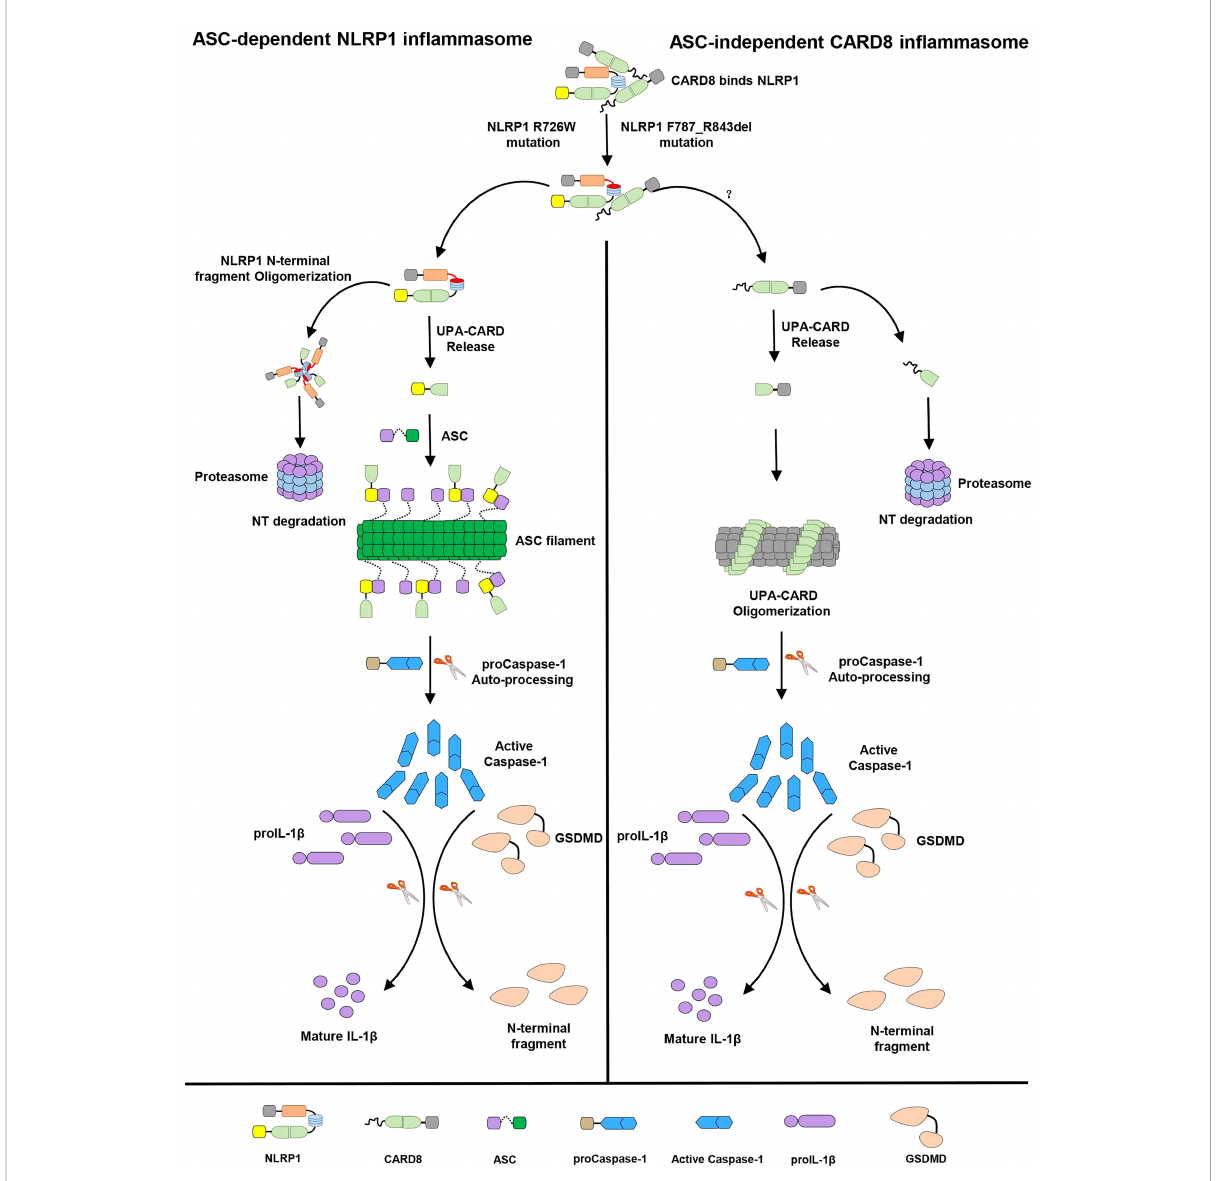
FIGURE 7 The sequential regulation and activation model of NLRP1 and CARD8 in fl ammasome. Full-length NLRP1 interacts with CARD8 to maintain the inactive state of NLRP1 and CARD8 in resting cells. The disease-causing mutations would lead to decrease the interaction between NLRP1 and CARD8 and lost the auto-inhibitory mechanism of NLRP1. Then NLRP1 and CARD8 N-terminal degradation by proteasome results in the release of the active C-terminal segment (UPA-CARD domain) from NLRP1 and CARD8. Oligomerized UPA-CARD fragments differentially recruit ASC or CASP1 to assemble the distinct in fl ammasomes by multiple molecular surfaces of